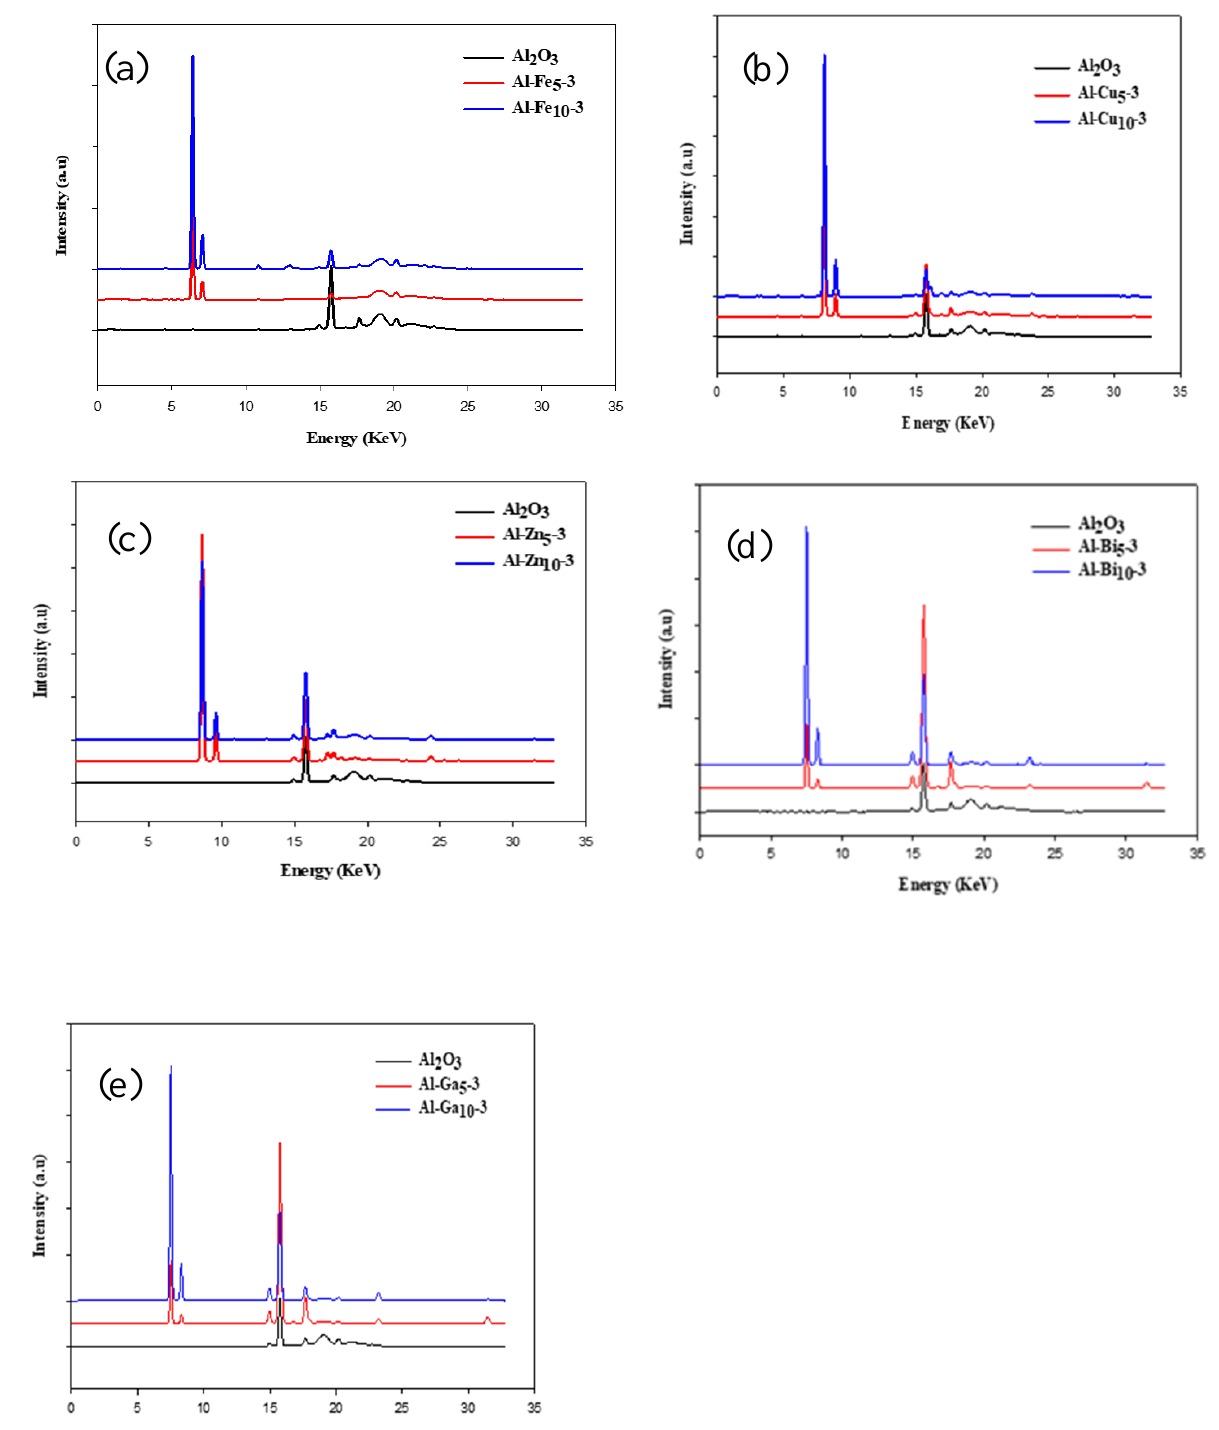
Figure 4. The XRF spectra of Al 2 O 3 and γ -Al 2 O 3 samples incorporated with selected metal oxides species: Fe ( a ), Cu ( b ), Zn ( c ), Bi ( d ) and Ga ( e ).